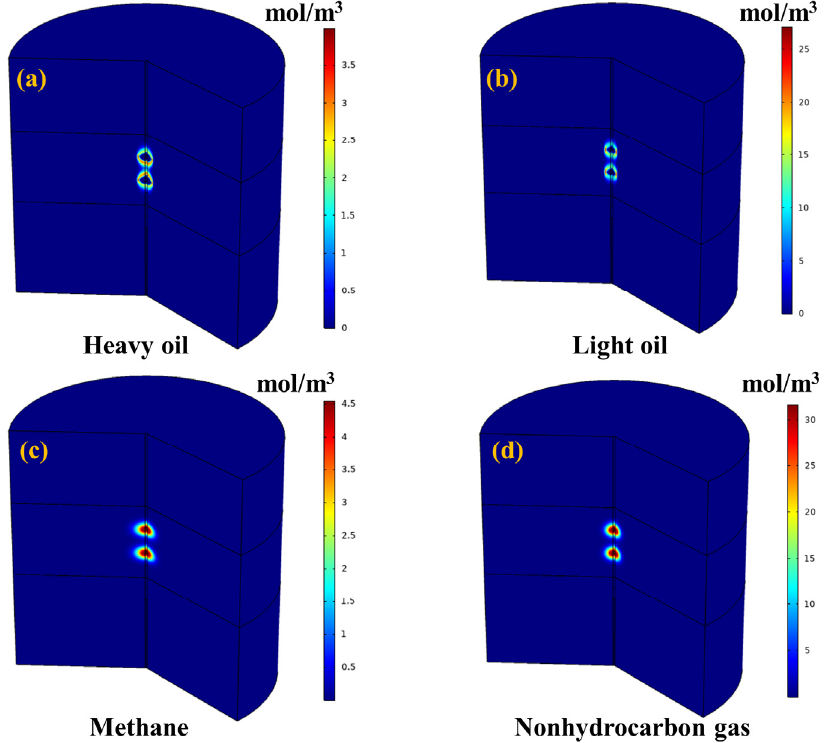
Figure 9. The distribution of retorting products at 600 days: ( a ) heavy oil, ( b ) light oil, ( c ) methane, and ( d ) nonhydrocarbon gas.